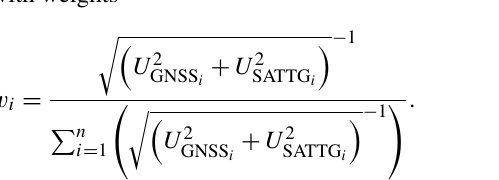
GNSS stations which are closer than 1 km to a TG. With